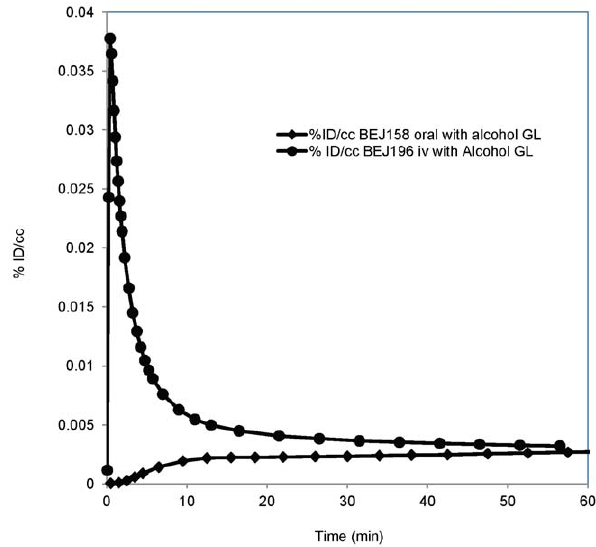
Figure 6. Time activity curves for the global brain uptake when tracer 1 was administered iv 35 min after baboon was pretreated with alcohol (22% ABV, 45 ml), and when tracer 1 was administered orally with alcohol (22% ABV, 45 ml). The brain exposure (AUC 60min ) was much higher when tracer 1 was administered iv. GL: Global